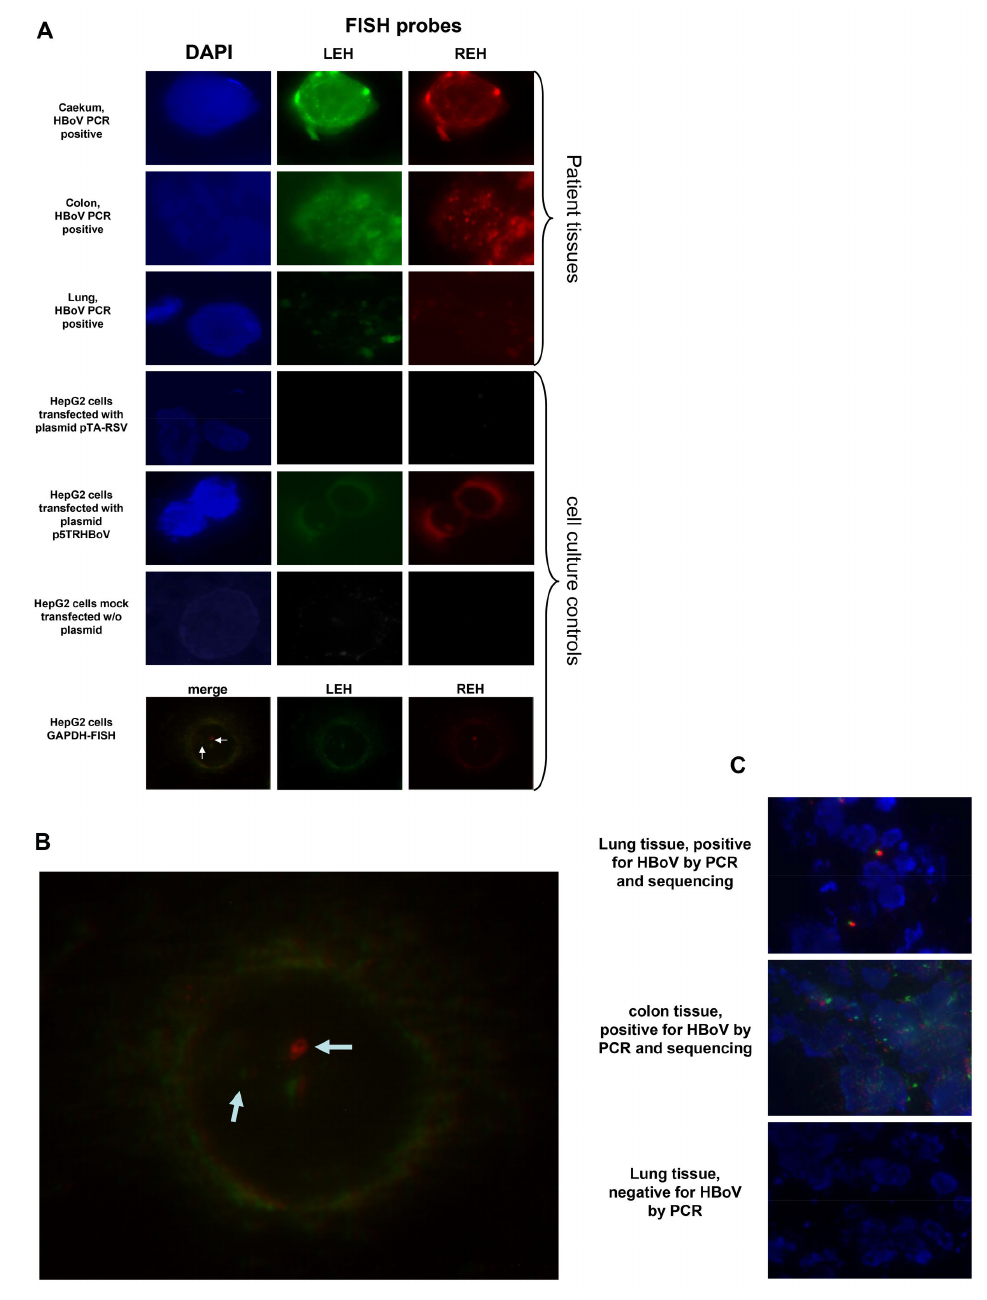
Figure 1. Sequence alignments of HBoV-specific PCR products from tumor tissue samples from lung and colorectal tumors. As reference sequences, the following GenBank accession number were used: HBoV-1=FJ858259(Bonn-1) a . aligned PCR product sequences obtained from tumor tissue samples. In total, 15 samples had enough DNA present after PCR amplification for direct sequencing. Sequences were blasted and aligned to the reference strain Bonn-1. It is obvious that all sequences were highly conserved and fully matched the reference sequence. Three sequences had additional non-HBoV sequence upstream of the aligned regions (shown in Figure 1b). b . Alignment of the upstream sequence present in three HBoV genomes isolated from tumor tissues. The upstream inserted sequence was observed in three samples that were independently DNA-extracted and analyzed by PCR and sequencing in three independent runs, thus excluding a single artifact or cross contamination event. Surprisingly, the underlined sequences fully matched the human DNA sequence from chromosome 5, reference sequences AC008698.6 ( Homo sapiens chromosome 5 clone CTB-70H11, bases 76065-76026) and AC025156.2 ( Homo sapiens 3 BAC RP11-494C5 from Roswell Park Cancer Institute, bases 130245-130284), indicating that HBoV is able to recombine with its host. doi: 10.1371/journal.pone.0068020.g001 PLOS ONE |